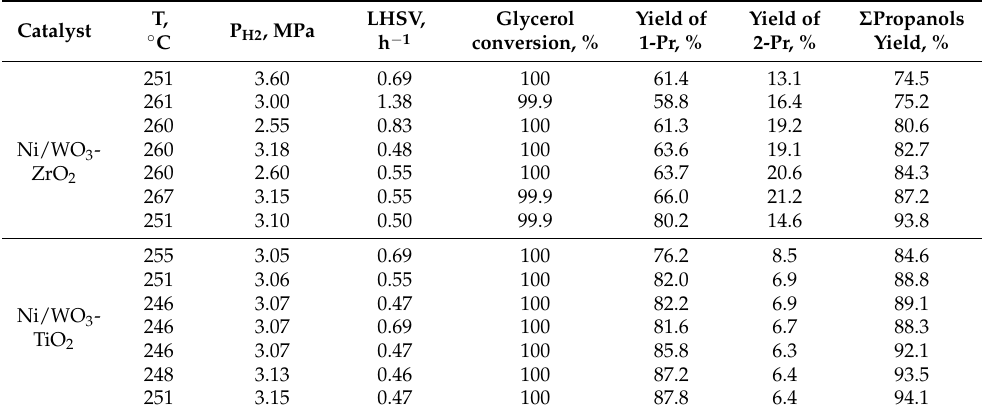
Table 4. The results of the glycerol hydrogenolysis over the 20%Ni/18%WO 3 -72%ZrO 2 and 16%Ni/20%WO 3 -80%TiO 2